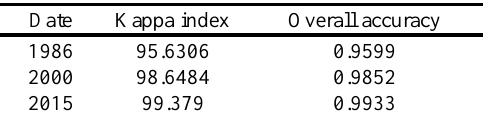
Table 1. Classifications Accuracy assessment results